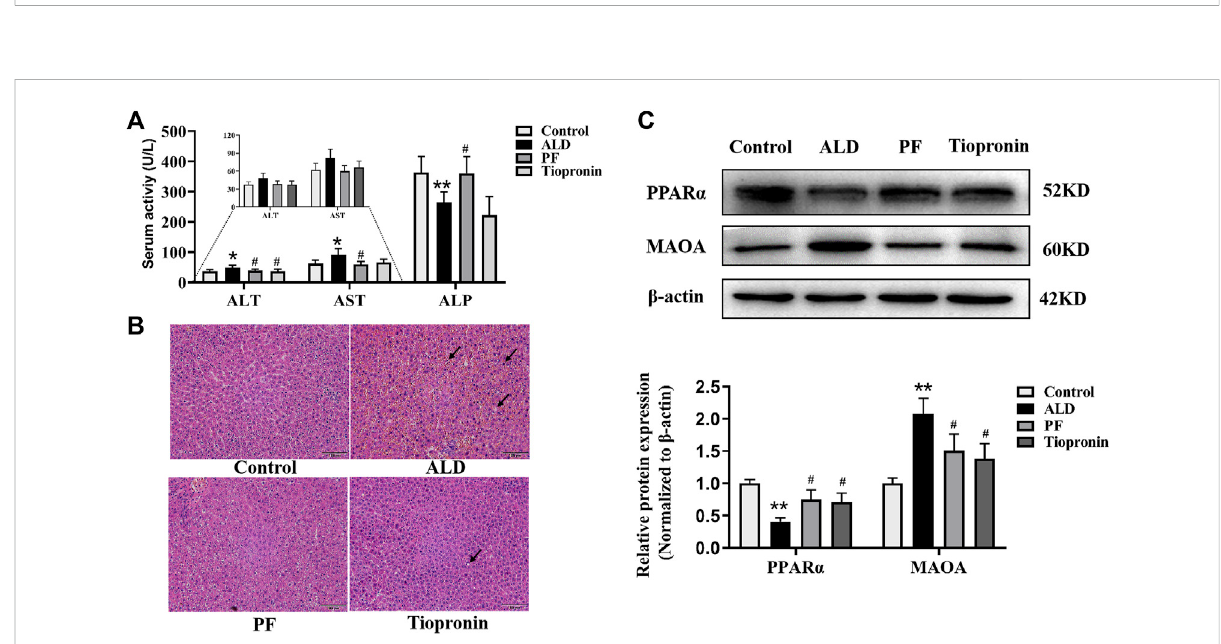
Protective effect of PF on ethanol induced rat liver injury. (A) Serum ALT, AST and ALP were measured using the automatic biochemistry analyzer. (B) Histological changes were observed using H&E staining (100×). The arrow indicates swelling and nuclear deviation, red blood cells over fl ow, or lipid vacuolation. (C) Effects of PF on PPAR- α and MAO-A protein levels in liver tissue based on the Western blotting assay. Data are presented as the mean ± SD ( n = 3), * p < 0.05 and ** p < 0.01 vs. control group. # p < 0.05 vs. model